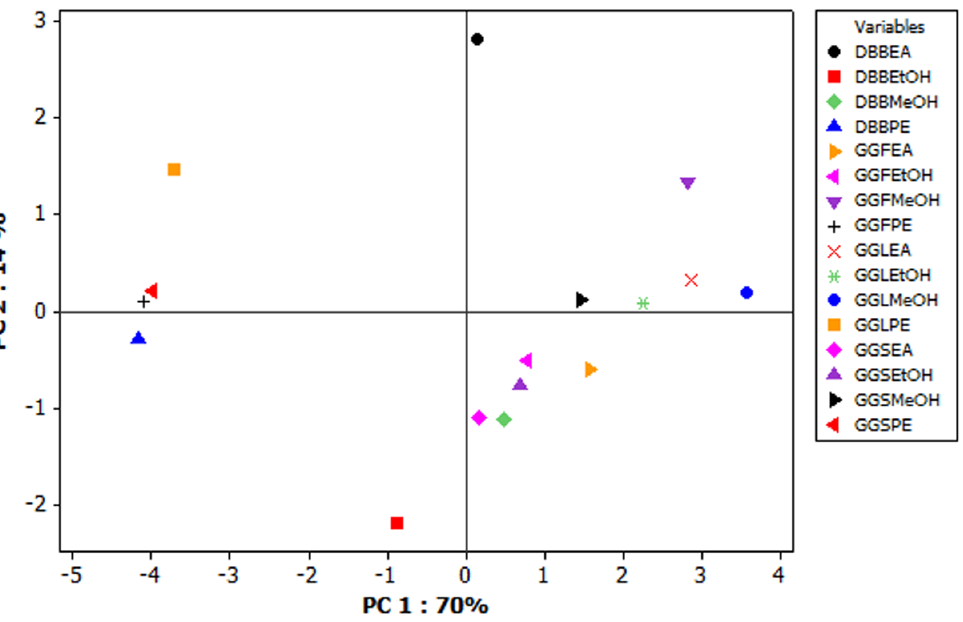
Figure 6. Principal component analysis of antioxidant activity represented by scatter plot. GGF - G. glauca flower; GGL - G. glauca leaf; GGS – G. glauca stem; DBB – D. bulbifera bulbs; PE: Petroleum ether extract; EA: Ethyl acetate extract; MeOH: Methanol extract; EtOH: Ethanol extract